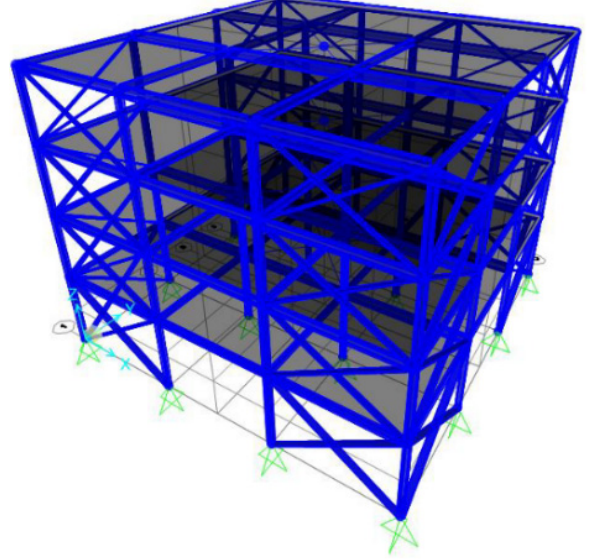
Figure 23. Multi-storey building model with SAP2000. Table 7. Loads applied to the multi-storey case studies.